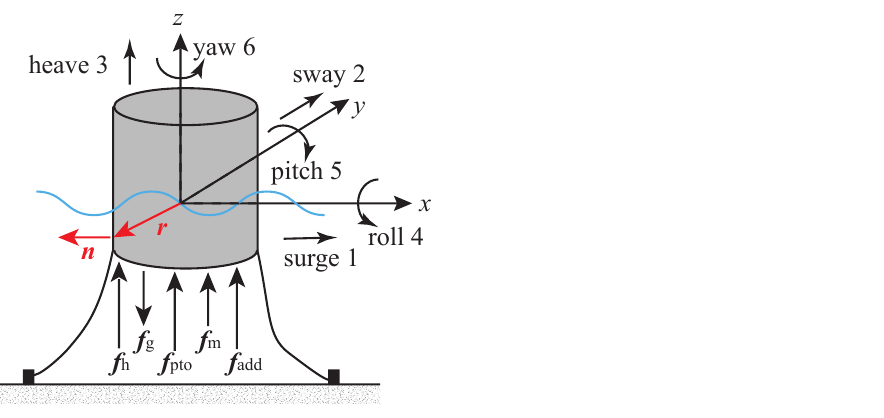
Figure 10. A floating cylindrical buoy is used to illustrate the dynamics of a generic PA device.